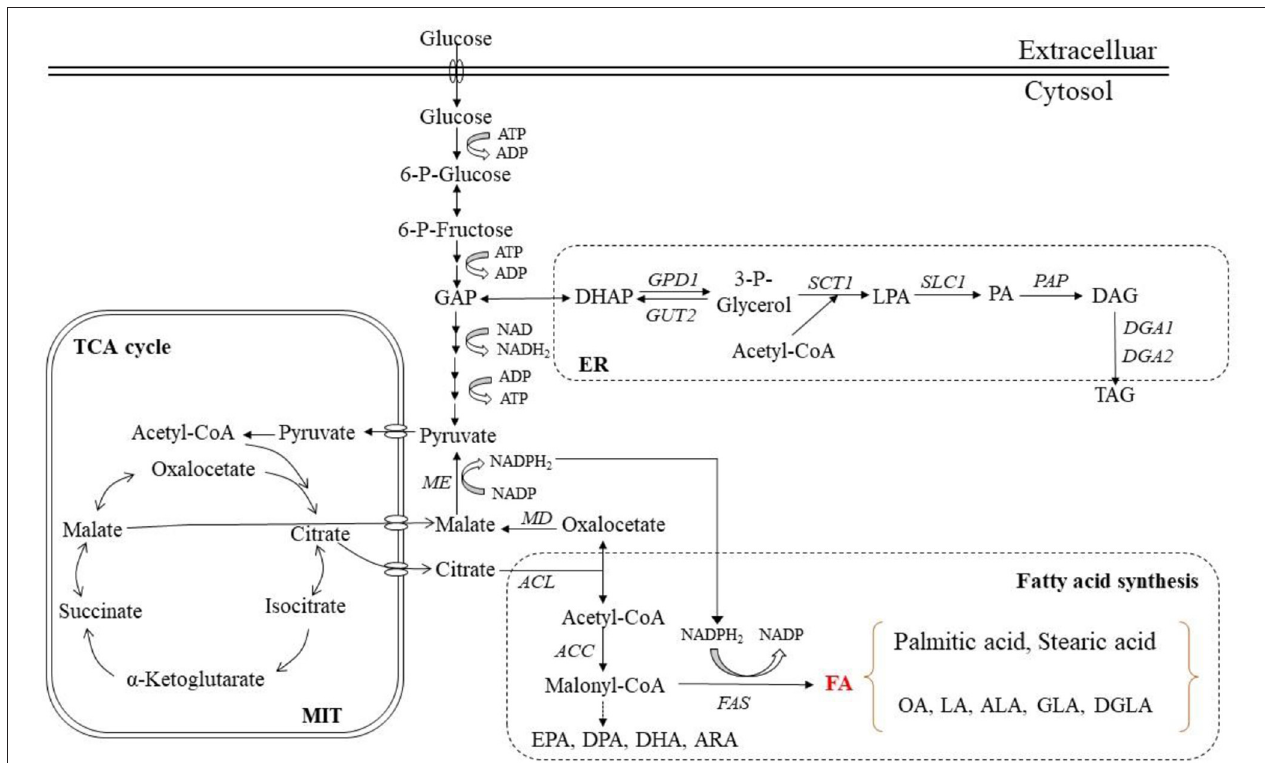
FIGURE 2 | TAGs and fatty acid synthesis in microbial cells. MIT, Mitochondria; ER, Endoplasmic reticulum; ACL, ATP-citrate lyase; FAS, Fatty acid synthase; MD, Malic dehydrogenase; ME, Malic enzyme; ACC, Acetyl-CoA carboxylase; TCA, Tricarboxylic acid cycle; DAG, Diacylglycerol; PA, Phosphatidic acid; TAG, Triacylglycerol; FA, Fatty acid; OA, Oleic acid; LA, Linoleic acid; ALA, α -Linolenic acid; GLA, γ -Linolenic acid; DGLA, Dohomo- γ -linolenic acid; ARA, Arachidonic acid; EPA, Eicosapentaenoic acid; DPA, Docosapentaenoic acid; DHA, Docosahexaenoic acid.